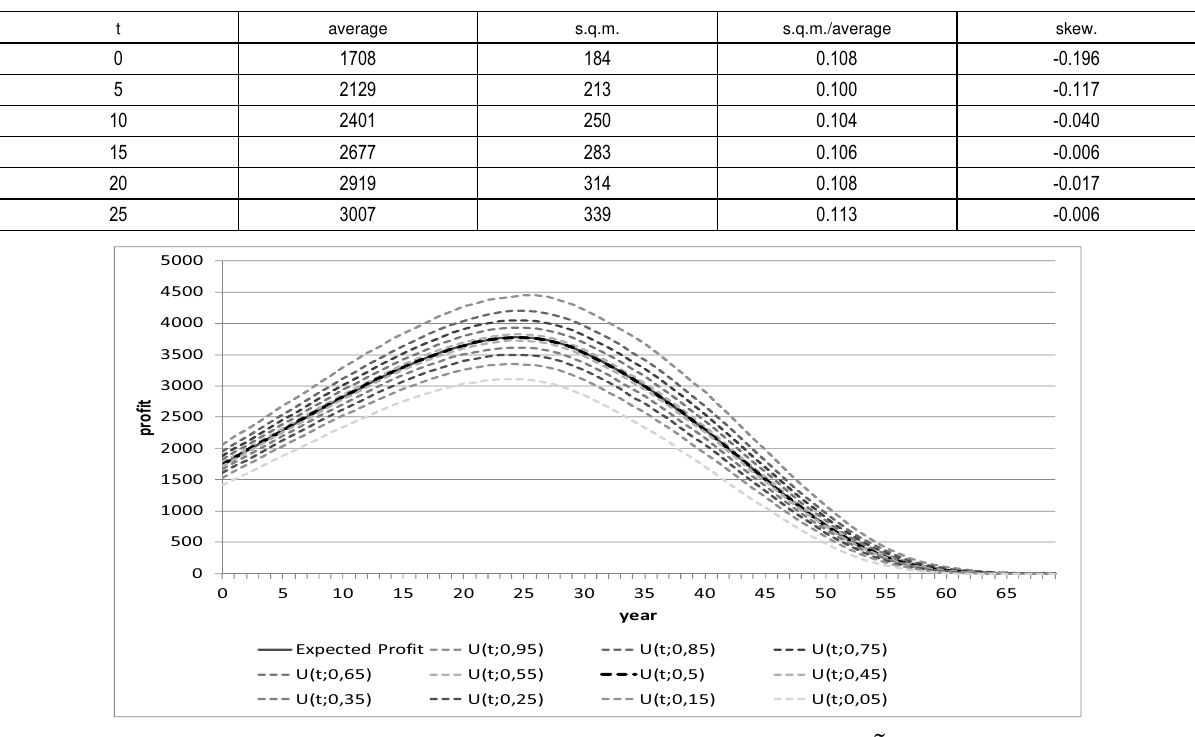
Fig. 1D. Average and percent values of the distributions of